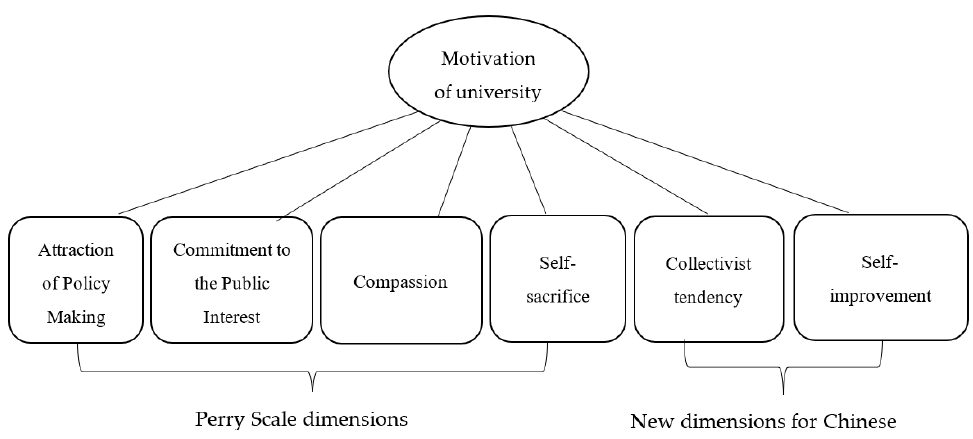
Table 1. Nodes table of public service motives.